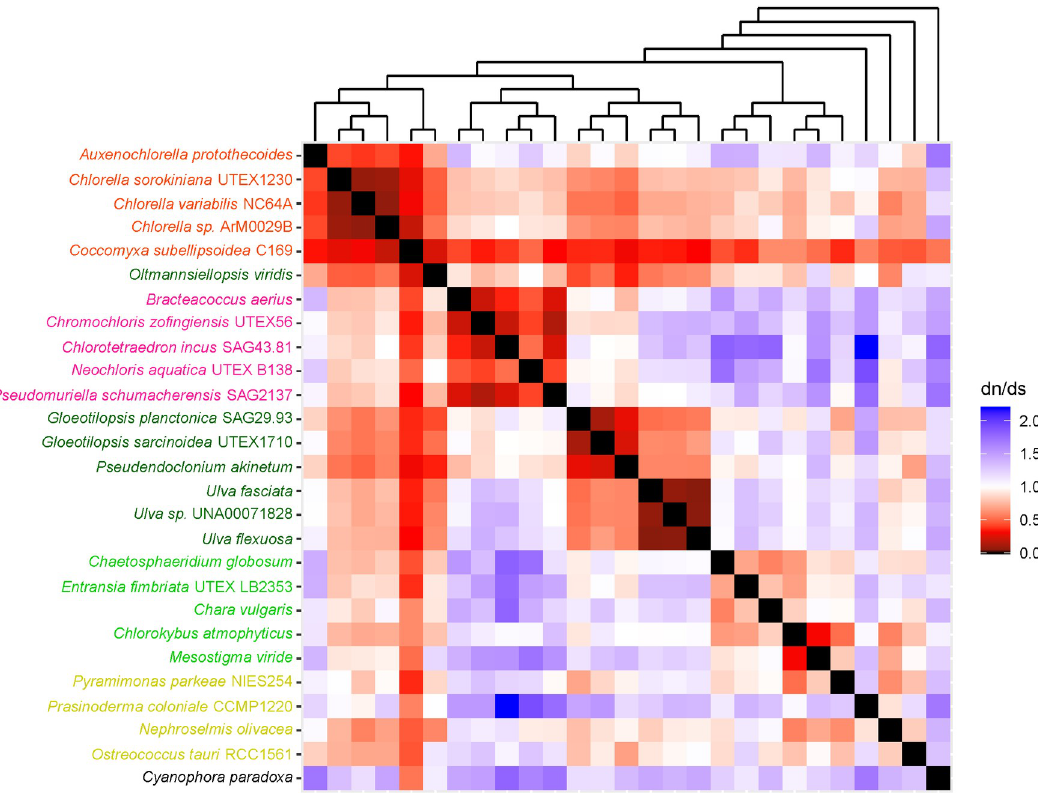
Fig 4. Heatmap of pairwise dN/dSdn/ds ratios calculated from alignment of plastid atp F. The scale bar represents color corresponded to pairwise dN/dS ratios. The cladogram above the heatmap corresponds to phylogenetic relationship estimated using algal atp